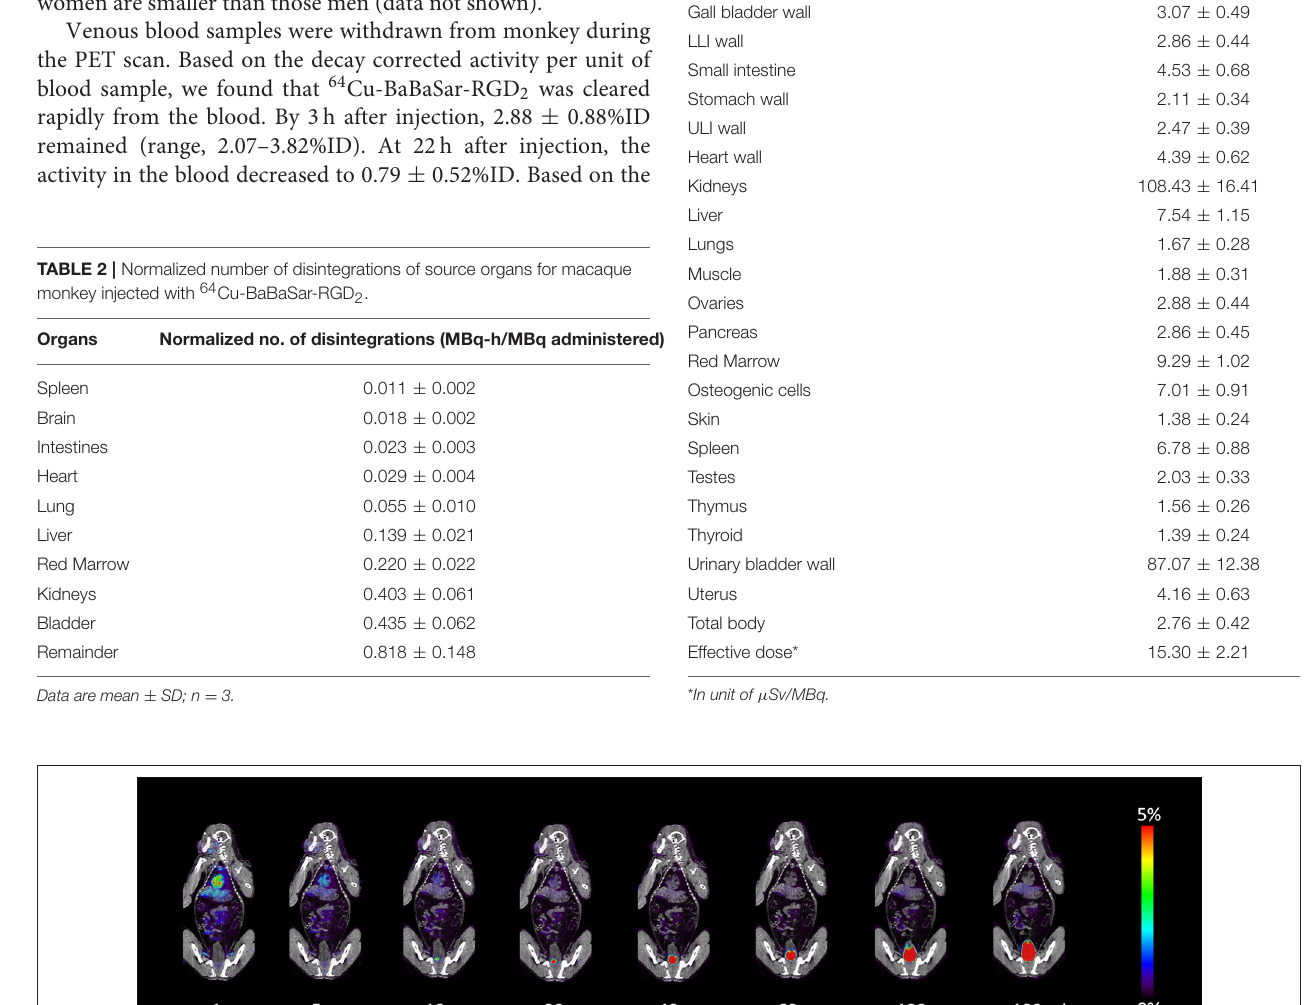
Frontiers in Physics |